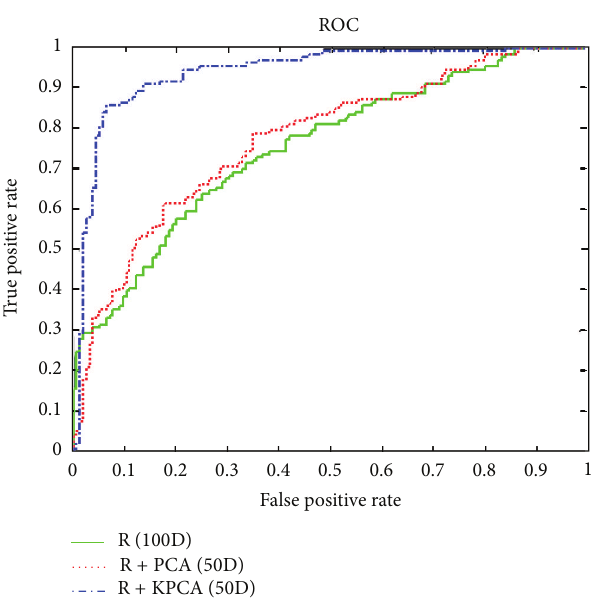
Figure 5: Comparison between gray-scale images in 100D, with PCA in 50D and kernel PCA in 50D.